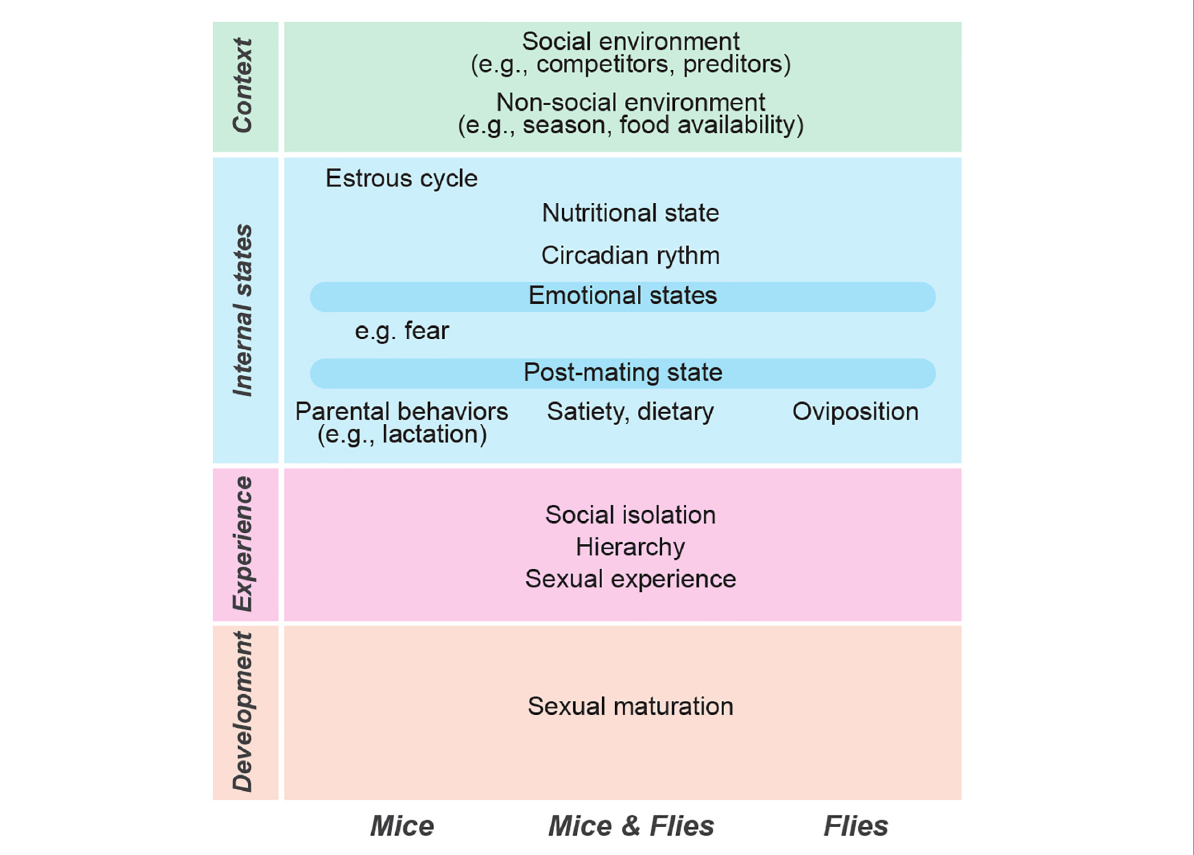
FIGURE1 Multiple factors drive flexible mating behaviors in mice and flies. The common factors that affect mating behaviors in both species are listed in the center. The unique factors that are known to affect only one species are shown in the left (mice) and right (flies).